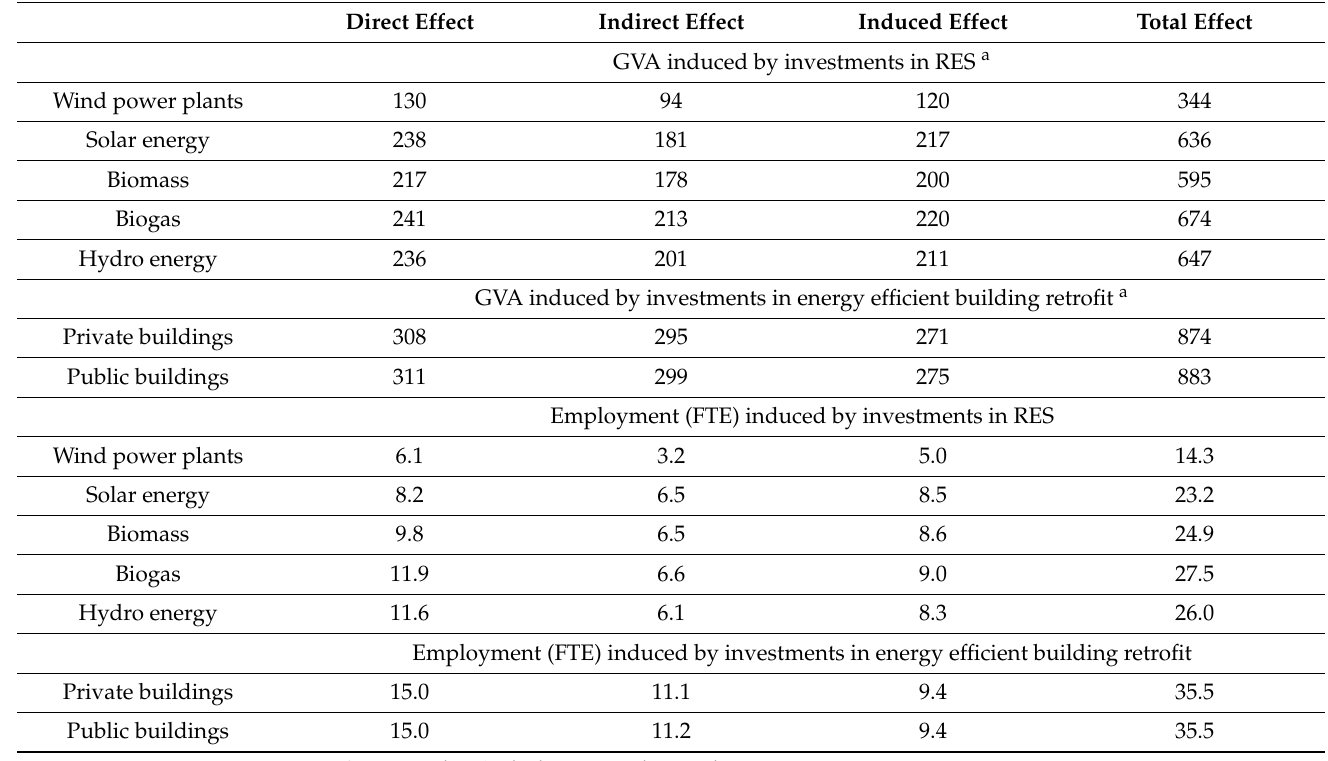
Table 2. Total gross value added (GVA) and employment effects per EUR 1 million